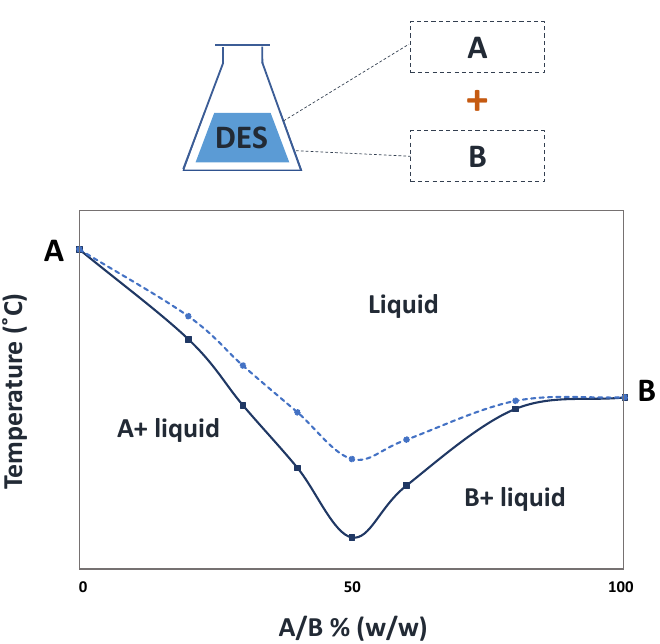
Figure 1. Solid-liquid phase diagram of a hypothetical DES (continuous line) and its comparison with the ideal behavior (dashed line). Table 1. DES application as alternative media for API solubilization and API formulation into its liquid form by the API–DES approach.